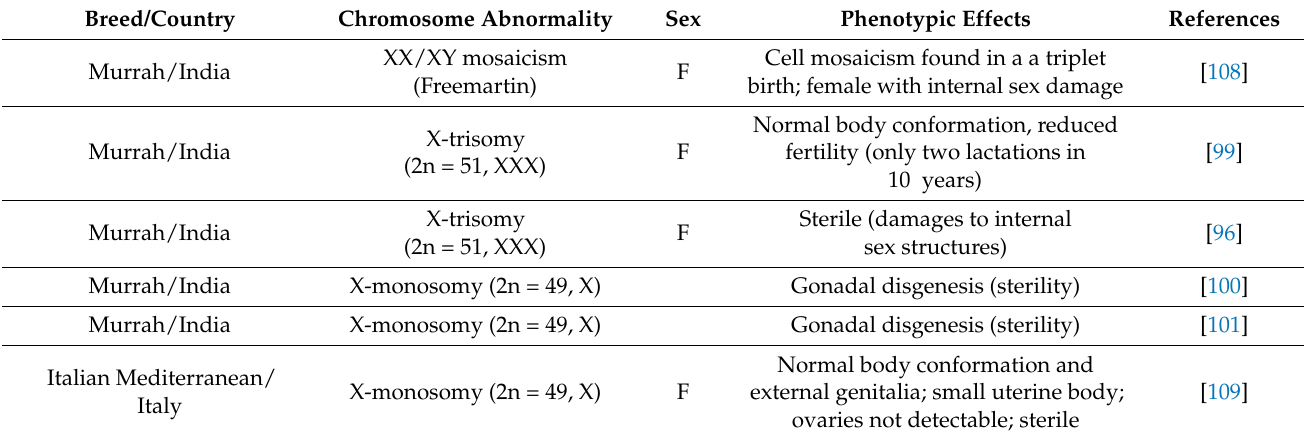
Table 3. Cases of river buffaloes (breed/country) per year affected by chromosomal abnormalities, their phenotypic effects, and